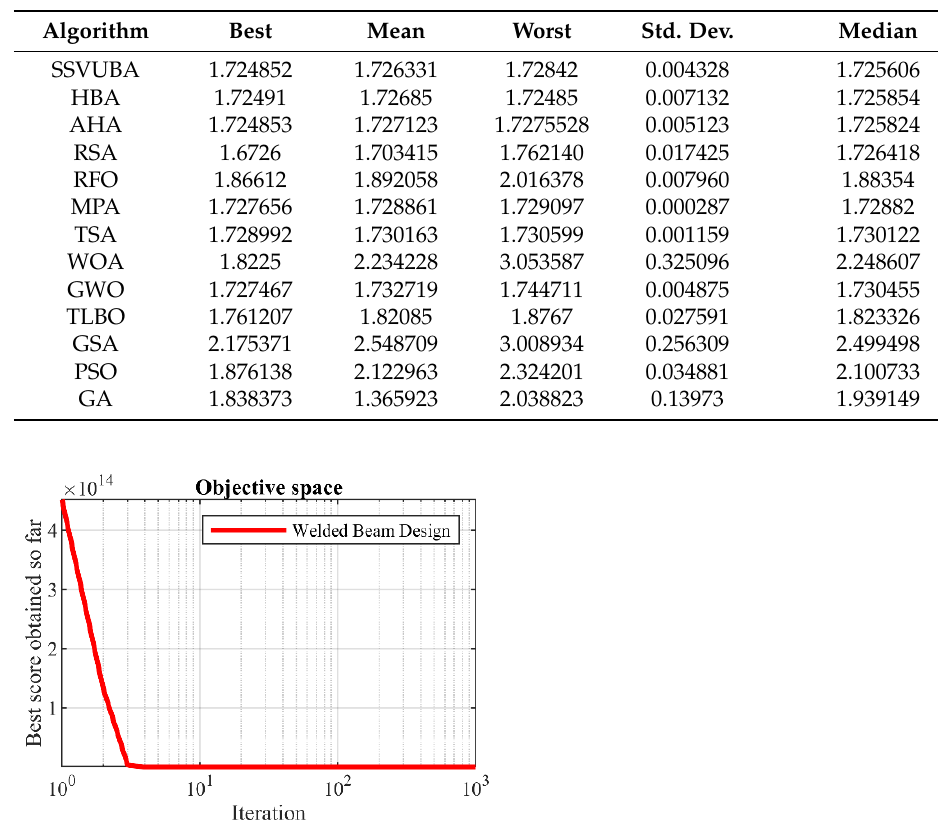
Table 15. Statistical results of optimization algorithms for the welded beam design problem.